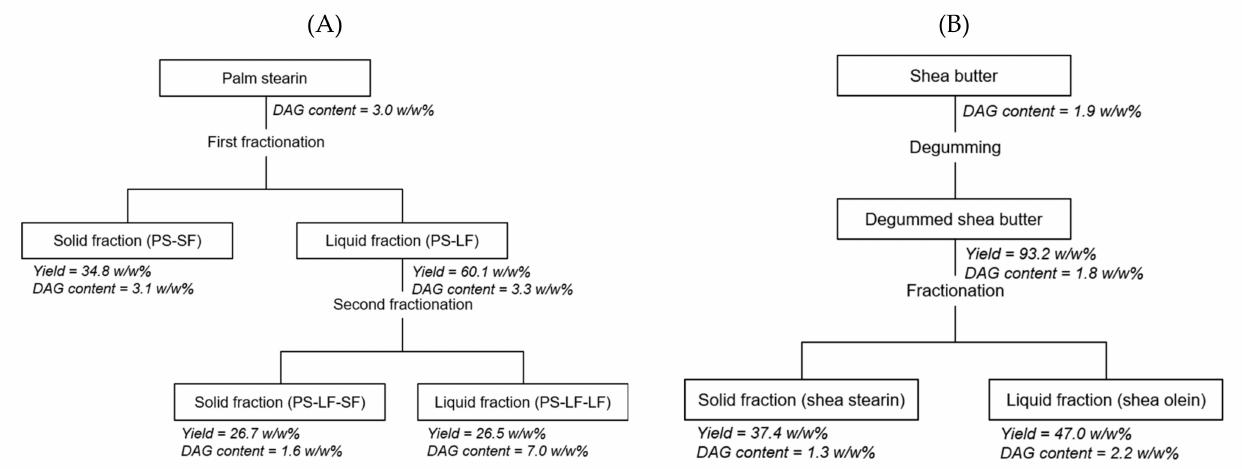
Figure 8. Preparation of 1,3-dipalmitoyl-2-oleoyl glycerol-rich fats by two-step hexane fractionation of palm stearin ( A ) and 1,3-distearoyl-2-oleoyl glycerol-rich fats by degumming of shea butter followed by hexane fractionation of the degummed shea butter ( B ). Fractionation was performed in a flat-bottom glass vessel (11 cm × 10 cm i.d.), using 50 g palm stearin or degummed shea butter under the best conditions established for the small-scale process, using another flat-bottom glass vessel (8 cm × 3.5 cm i.d.). The yield of each fraction was expressed as a percentage of the initial palm stearin weight or shea butter weight. The diacylglycerol (DAG) content of each fraction was expressed as a percentage of the weight of the